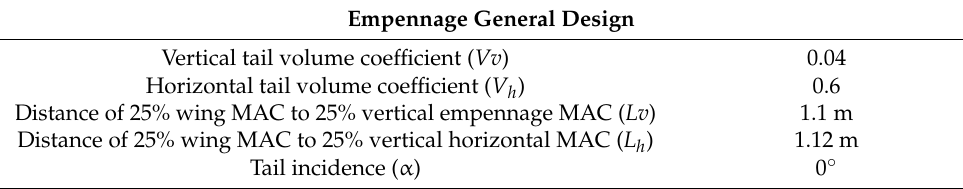
Table 5. Empennage